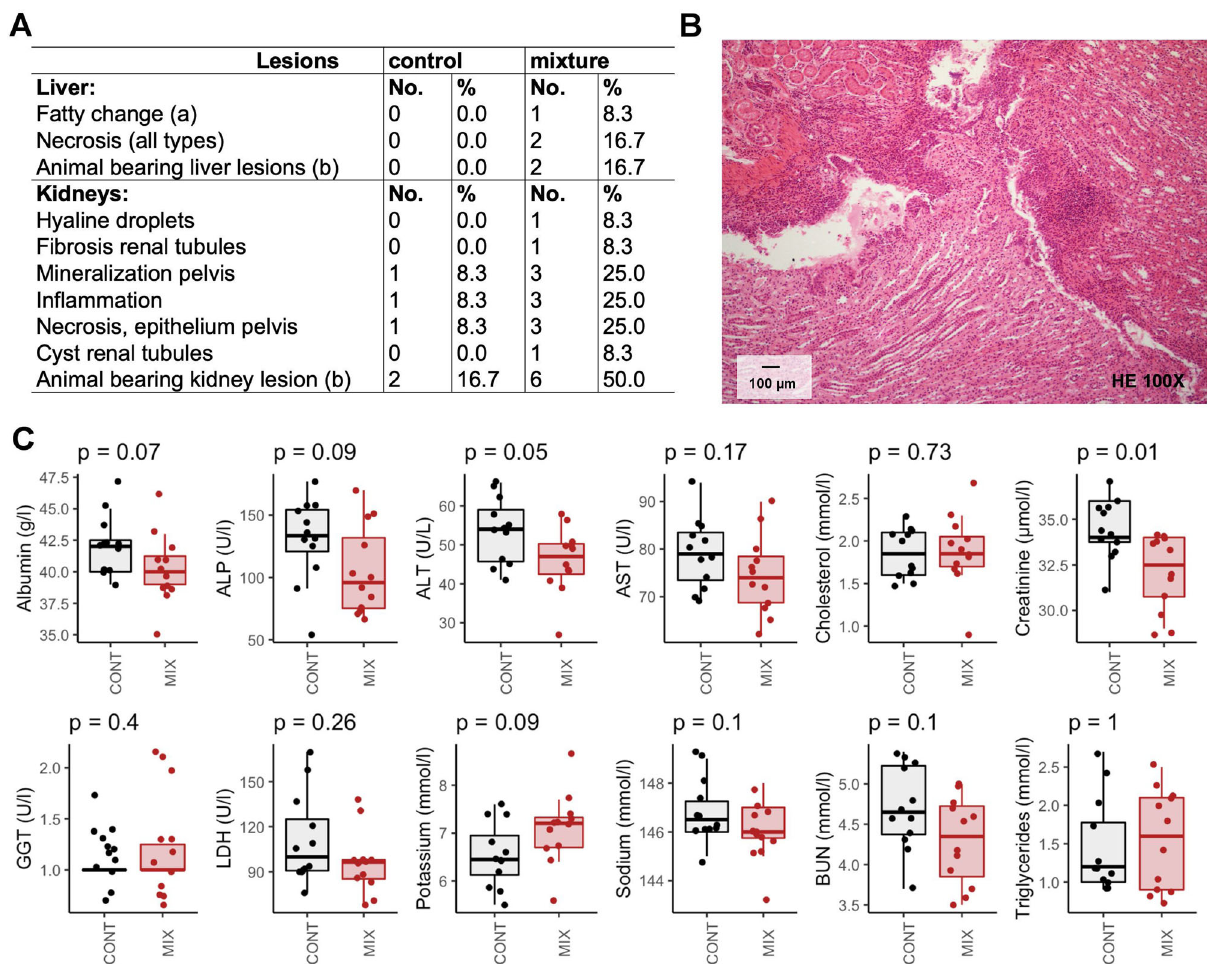
Fig. 2 Analysis of regular clinical and biochemical markers provided limited insight into the effects of a mixture of pesticides at their acceptable daily intake in Sprague – Dawley rats. Incidence in signs of anatomical pathologies in liver and kidneys ( A ). Focal in fl ammation of moderate to severe grade localized in the pelvic area in a rat exposed to the pesticide mixture; magni fi cation ×100 ( B ). Standard serum biochemistry analysis showed only a decrease in creatinine levels ( C ).